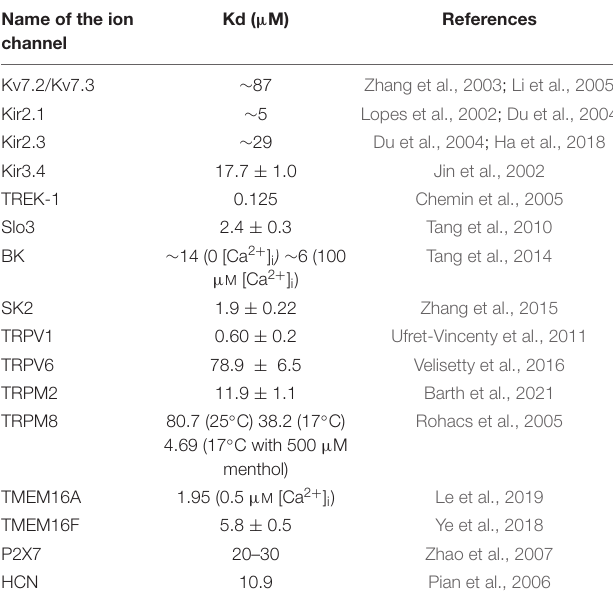
TABLE 1 | The PtdIns(4,5)P 2 affinity of individual ion channels. Name of the ion